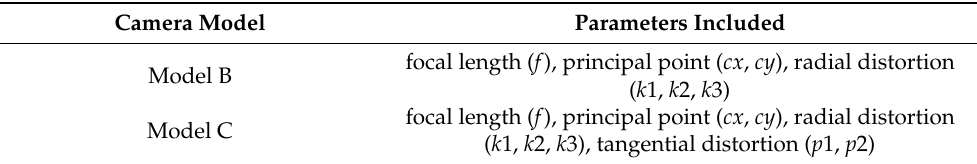
Table 4. Camera models and their parameters tested in this